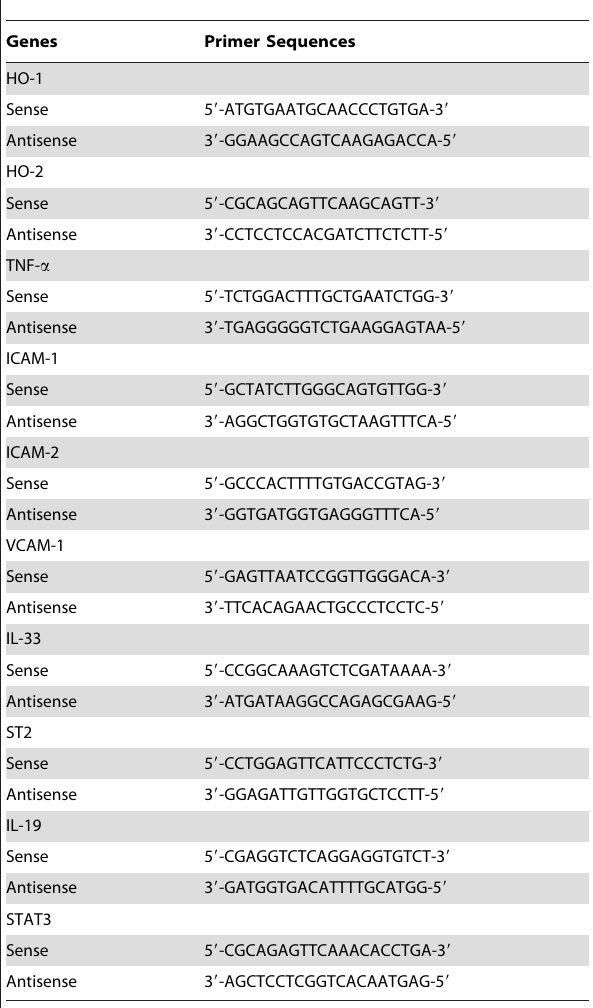
Table 1. Primers used for RTQ-PCR in porcine lung and myocardial